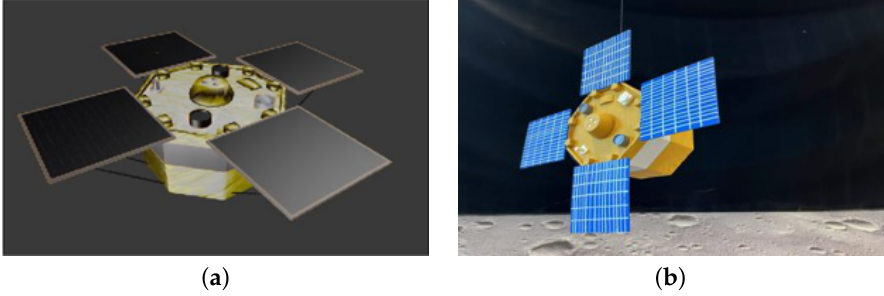
Figure 2. The CAD model and 3D printed model of ArcimSAT: ( a ) CAD model. ( b ) 3D printed model.